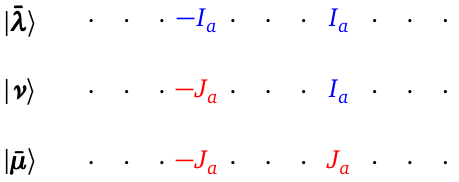
→ − J , while ¯ µµµ differs a a